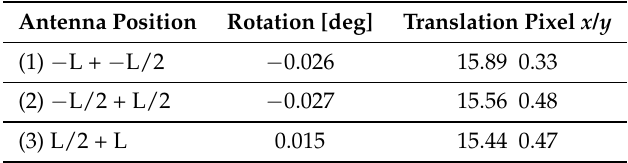
Figure 14. 2D Example of Fourier–Mellin-Invariant (FMI) descriptor pair. The pair shows descriptors from two neighboring scans [ − L − L/2]. Since the simulation parameters include only a translational shift, both descriptors should be identical in the ideal case, representing the rotation parameter as a horizontal shift between the descriptor pair. Table 4. FMI registration results (rotation,